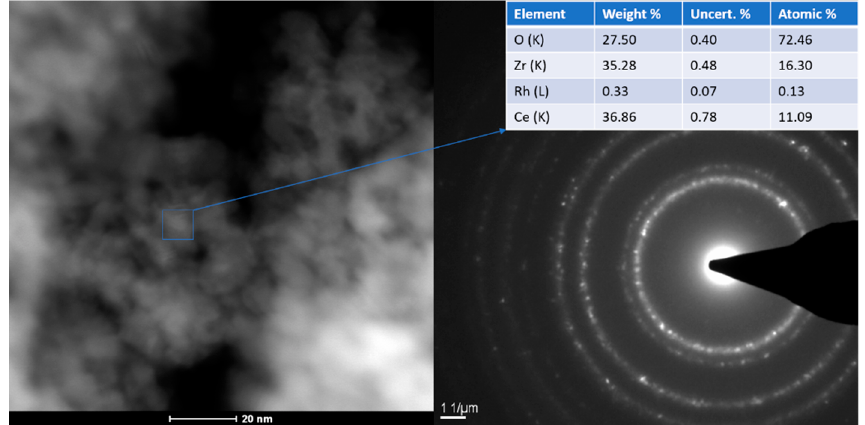
Figure 21. SAED and Energy Dispersive X-ray Spectrometry (EDS) analyses carried out on a Rh containing area of the spent not-reduced CZOm supported catalyst after reaction at low temperature.